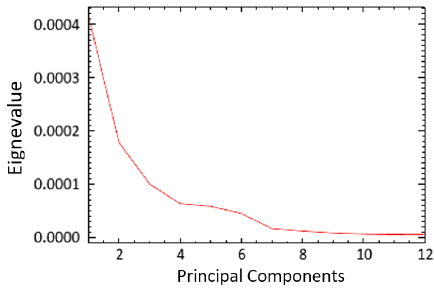
Figure 4. The PCA eigenvalue plot